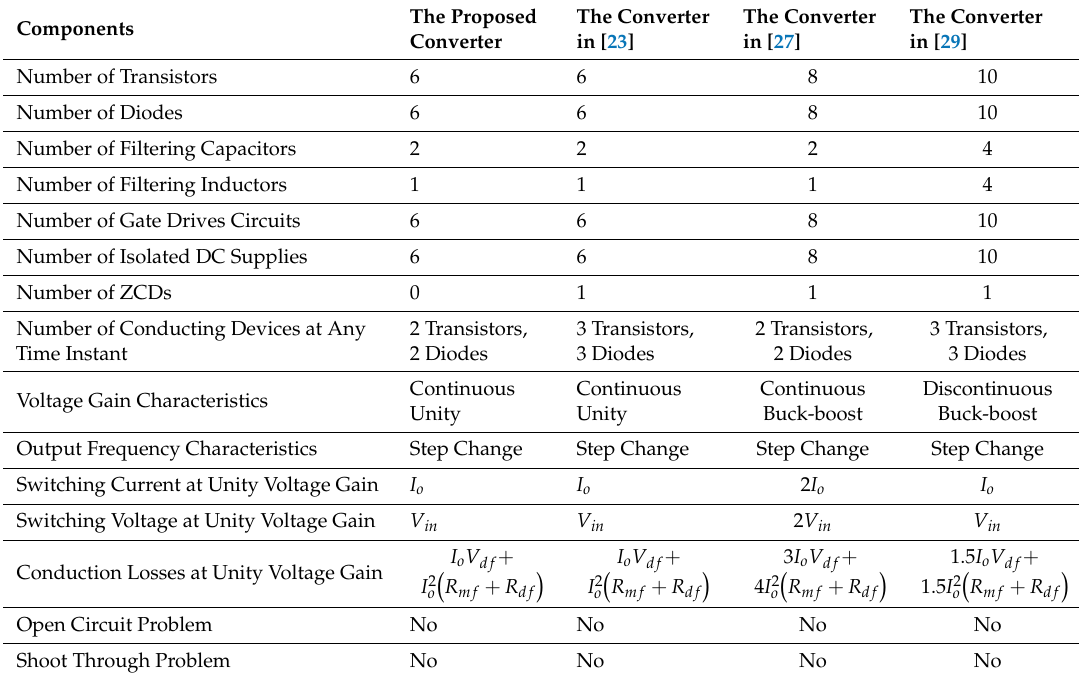
Table 2. Comparison with the existing converters in terms of components count and performance